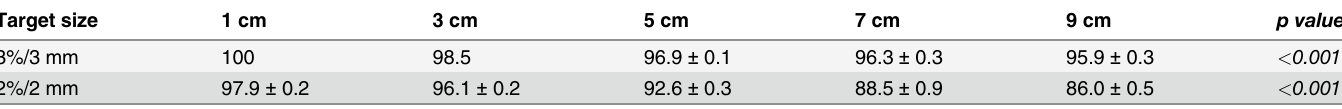
Table 3. Comparison of gamma passing rates at the diode level according to target size. Target